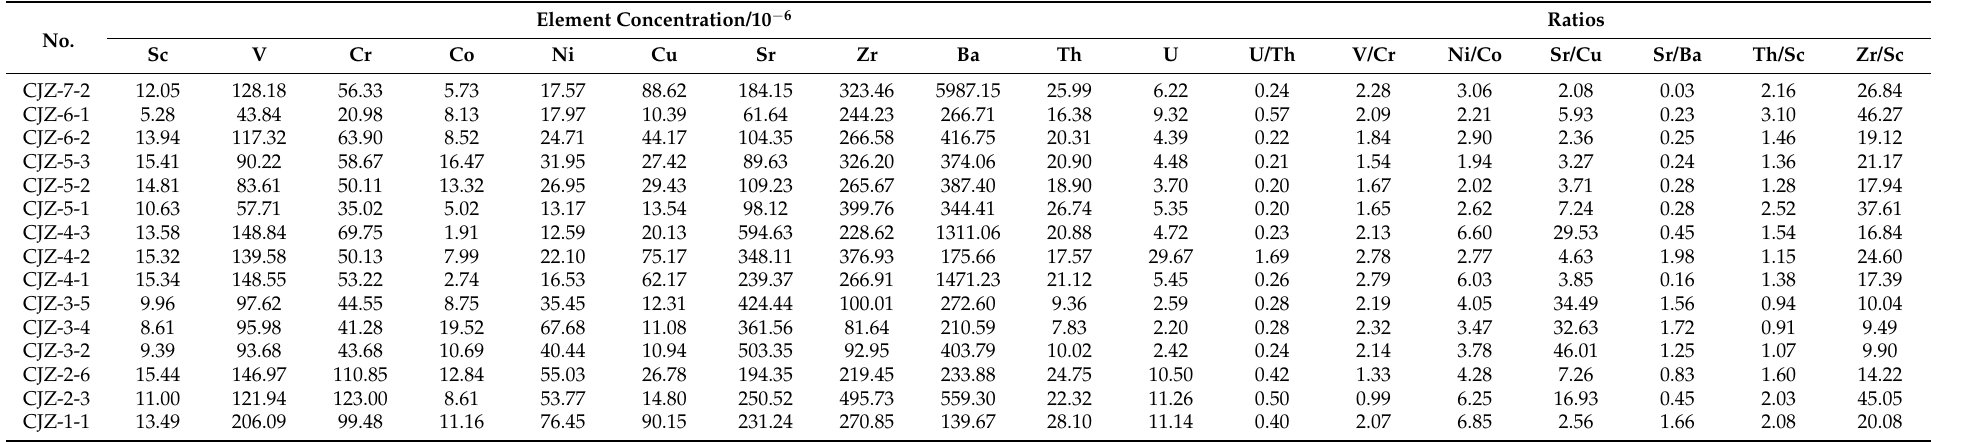
Table 4. Trace element compositions of Benxi − Shanxi Formations in the Liulin